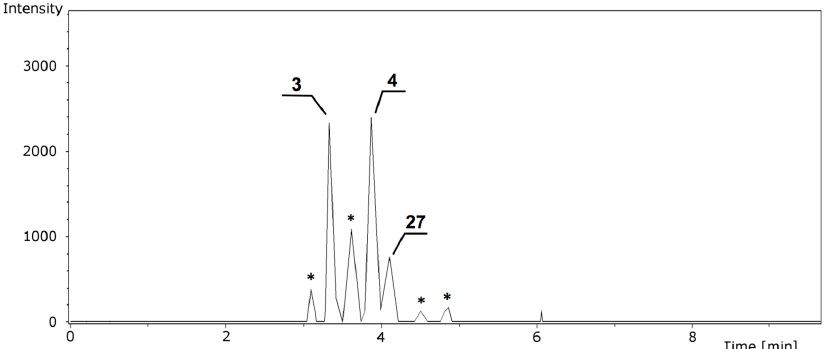
Figure 2. Extracted ion chromatogram at m / z 815 showing all isomeric and isobaric ions. Asterisks indicate isomeric compounds not possible to distinguish due to very similar spectra to compounds 3 , 4 or 27 .